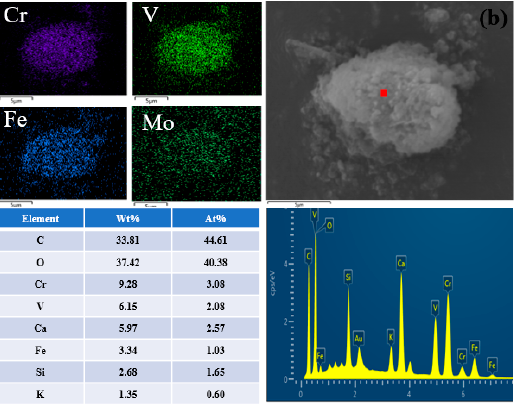
Figure 10. Phase-change diagram of HCVR during the entire process ( a ) and SEM-EDS characteriza- tion of the tailings ( b ).